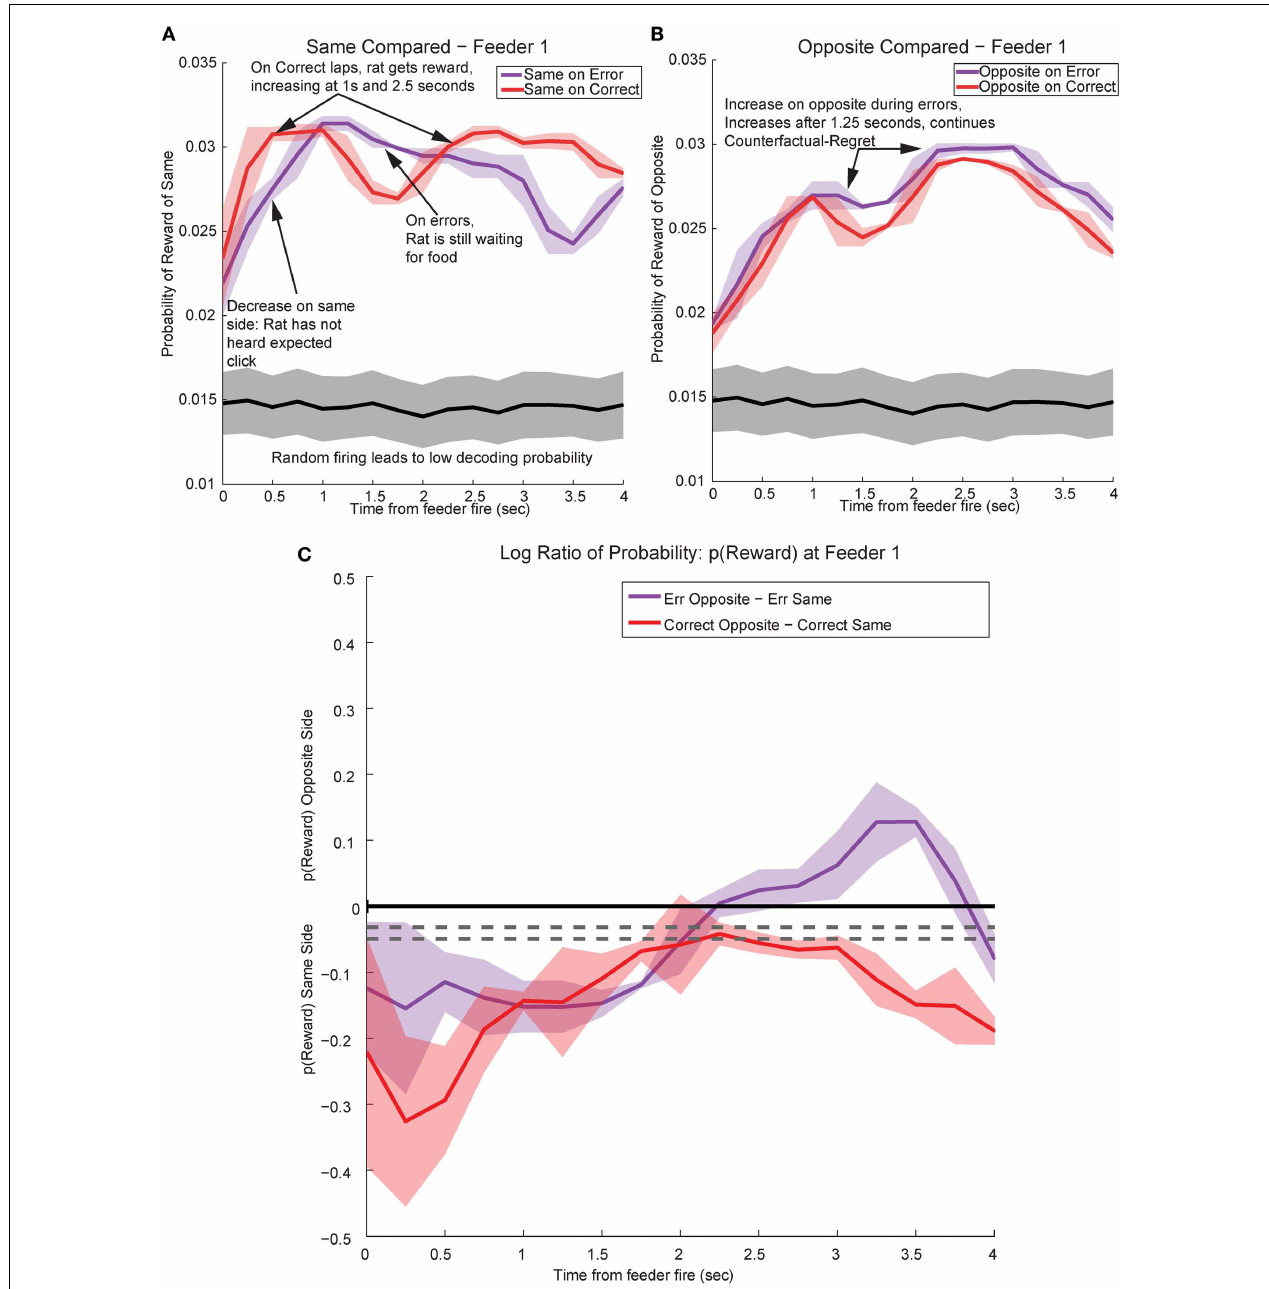
p (Reward opposite ) on error and correct are similar, however, once the rat realizes his error and begins to experience disappointment, neural representations increased to the opposite would-have-been rewarded site.This increase in p (Reward) to the opposite would-have-been rewarded side represents the counterfactual signal. (C) The log ratio between the local and non-local representations of reward, p (Reward same ): p (Reward opposite ), for correct feeder passes and error passes. Data was smoothed using a 500-ms moving average. Gray lines represent the upper and lower quartiles for shuffled control, based on shuffling interspike intervals and re-calculating the decoding using unshuffled tuning curves. On errors, the log ratio of p (Reward) at feeder 1 remained local, [ p (Reward same ) > p (Reward opposite )], following arrival at the feeders from 0 to ∼ 2s, then switched to a non-local representation [ p (Reward same ) < p (Reward opposite )]. In contrast, on correct laps, the log ratio of p (Reward) at feeder 1 remained local for the duration of the animal’s pause at the reward